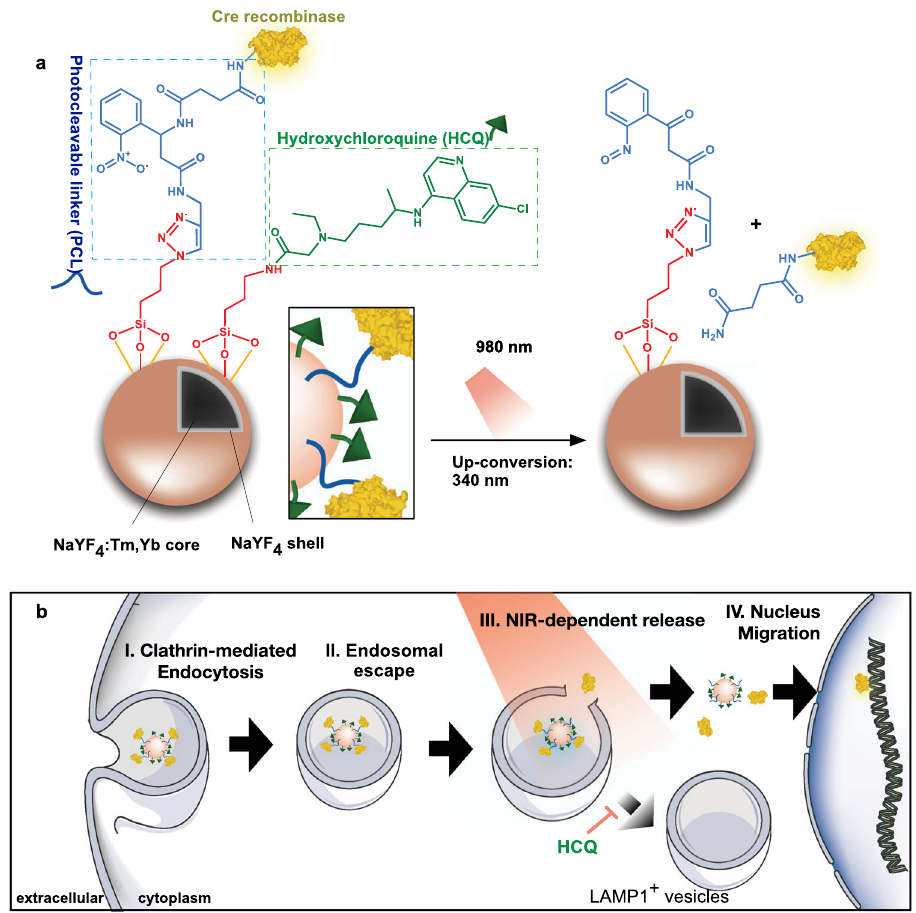
Fig. 1 Composition and action mode of Cre-UCNPs. a Schematic representation of Cre-UCNPs. Initially, the amine groups of silanized UCNPs were reacted with hydroxychloroquine (HCQ) while the azide groups were used for the immobilization of NLS-Cre recombinase through a photo-cleavable linker (PCL). NLS is a nuclear localization signal. Cre-UCNPs had approximately 60 molecules of HCQ and 4 molecules of Cre recombinase per NP. Upon irradiation with a 980 nm NIR light, the UCNP core emits light in the UV range. PCL is cleaved by the 340 nm radiation emitted from UCNP and releases the enzyme from the NP. b Gene edition mediated by Cre-UCNPs. Cre-UCNPs were internalized by cells through endocytosis. HCQ present in the NP has a lysosome inhibitory effect and assists on the release from the endosomal compartments. Upon NIR activation, Cre recombinase is released, diffuses to the nucleus with the help of NLS sequence and induces recombination. Adapted from images obtained from Servier Medical Art by Servier (http://smart.servier.com), licensed under a Creative Commons Attribution 3.0 Unported License, and from RCSB Protein Data Bank (doi: 10.2210/pdb1q3v/pdb) using the 3D View